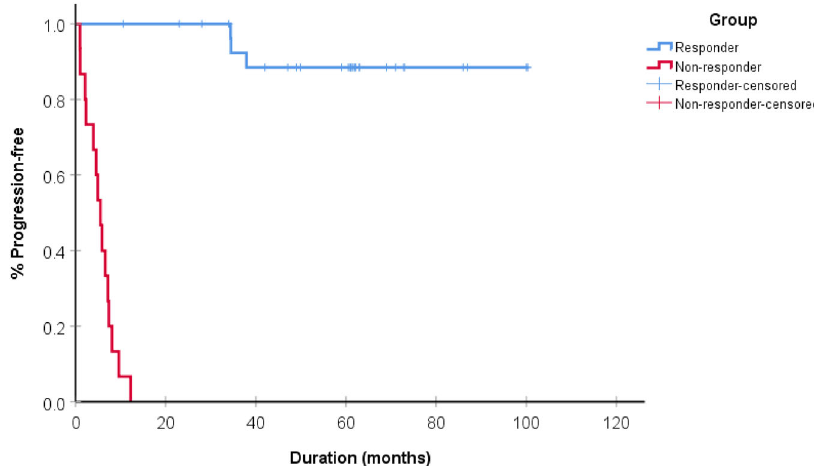
Fig. 2 Kaplan – Meier curves comparing progression-free survival for responders and non-responders. The median PFS of non-responders was 5.5 months (95% CI, 5.0 – 5.9), and the median PFS of responders was not reached ( P < 0.001 by log-rank).